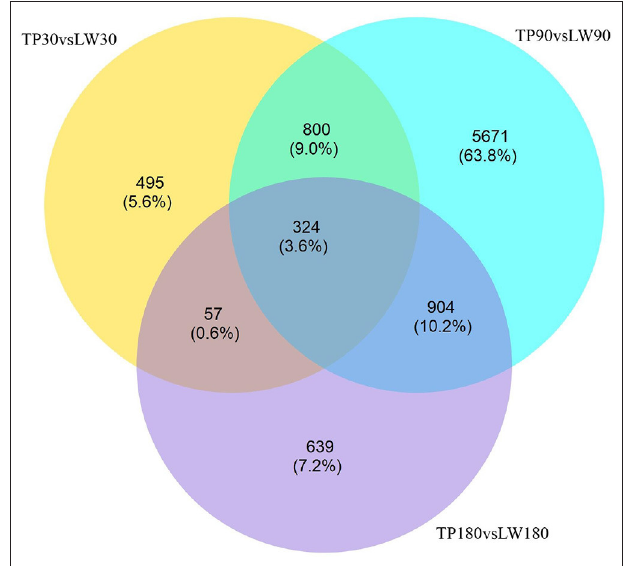
FIGURE 2 | Differential genetic Venn